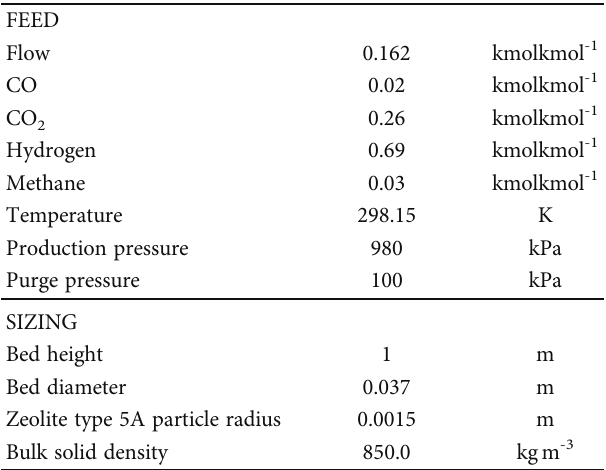
Table 12: Start-up parameters of the PSA process for the puri fi cation and production of